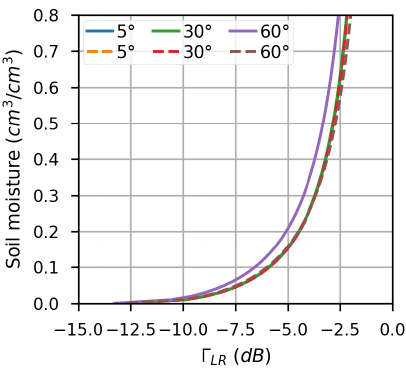
Figure 3. The relationship between reflectivity and soil moisture under different incidence angles of GPS signal and the performance of incidence angle correction.